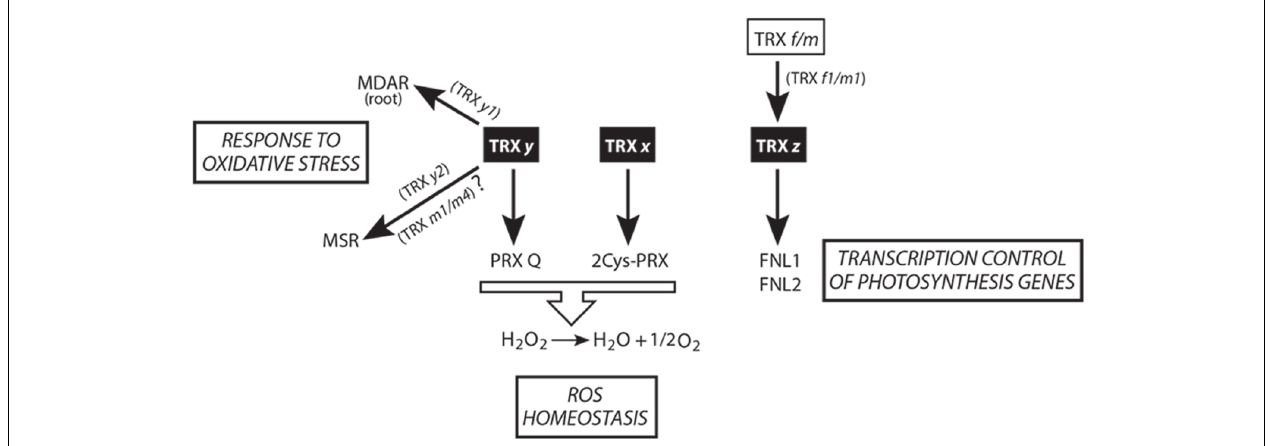
FIGURE 2 | Scheme ofTRX x , y , and z -mediated redox signaling in plastids. The central physiological processes regulated by these isoforms are shown.